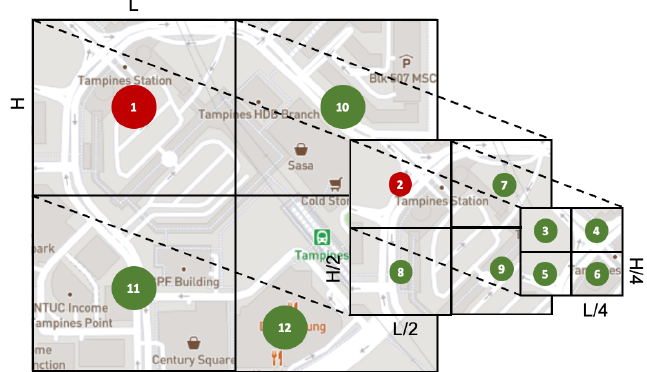
Figure 3. The variable bounding box approach starts by dividing the study area into a series of sub-bounding boxes of a certain dimension and recursively dividing each sub-bounding box into boxes of smaller dimensions each time the number of results returned reaches the upper limit. The number in each circle represents the sequence in which an example query was constructed and called. The red circle indicates that the number of results returned reaches the upper limit, while a green circle indicates that the number of results returned falls below the upper